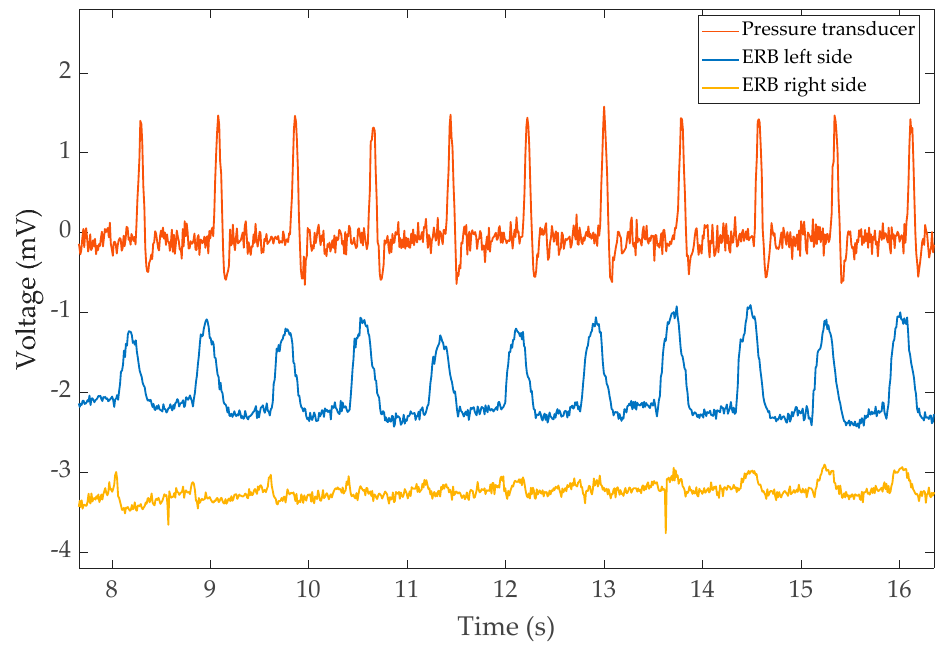
Figure 5. The pulse recorded from the pressure transducer and the corresponding reading from left/right bands of VitalCore. The readings were taken while holding breath.